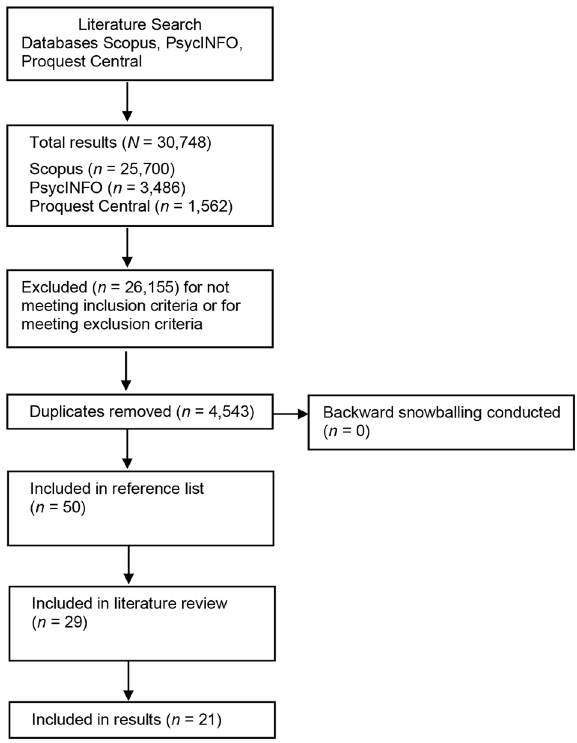
Fig. 1 PRISMA model for systematic review studies fl ow chart. Flow